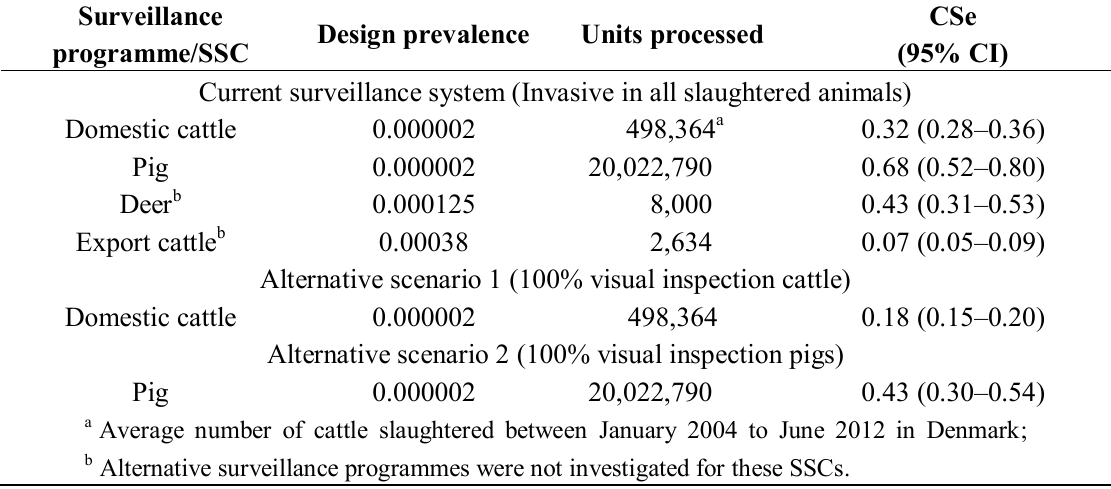
Table 1. Results of simulations with 10,000 iterations for the sensitivities (CSe), with design prevalence and units processed for each of four surveillance system components (SSC) ( i.e. , all slaughtered animals subjected to invasive meat inspection as well as cattle tested prior to export) in the current Danish surveillance programme for bovine tuberculosis and for four alternative meat inspection surveillance programmes involving more visual meat